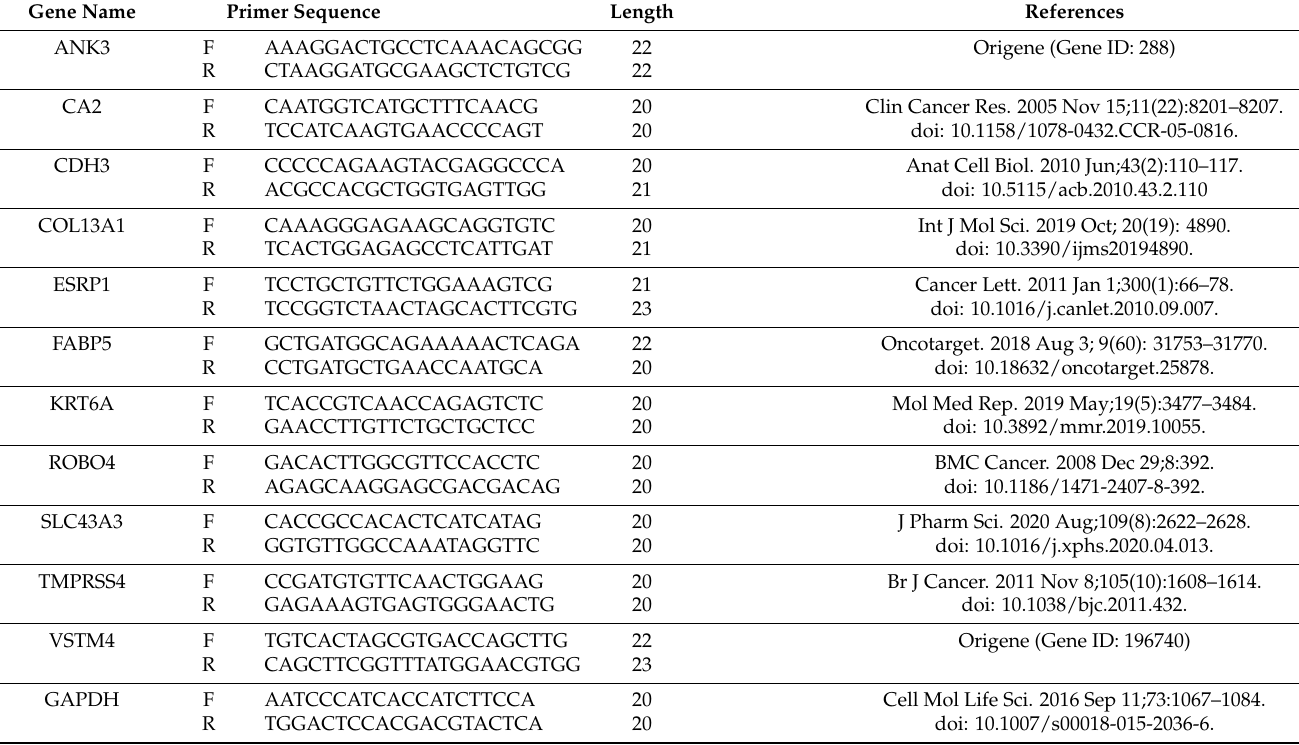
Table 7. Primer lists of qRT-PCR (5 (cid:48) -> 3 (cid:48)